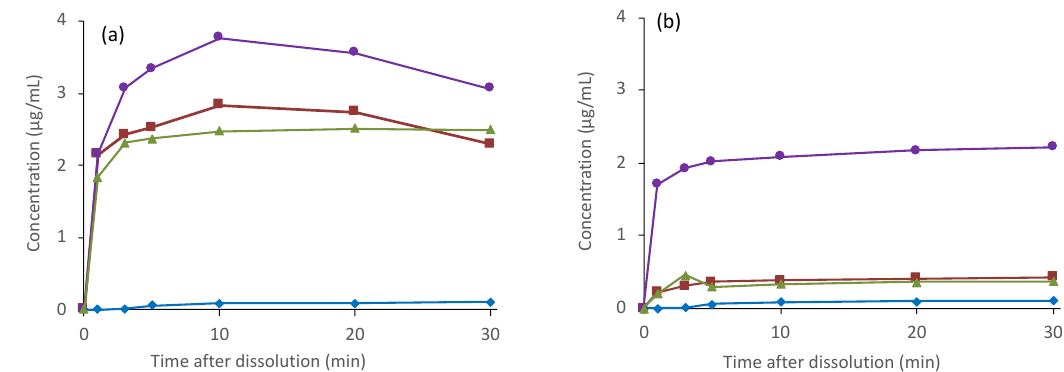
Figure 4. Concentration profiles of ALZ eluted from crystalline ALZ and ALZ ASDs in the LLPS dissolution test. Filtration was performed using syringe filters with pore sizes of ( a ) 0.7 μ m or ( b ) 0.2 μ m. Symbols: Crystalline ALZ ( ◆ ), PVPVA ASD ( ■ ), HPMCAS ASD ( ▲ ), Eudragit ASD ( ● ).